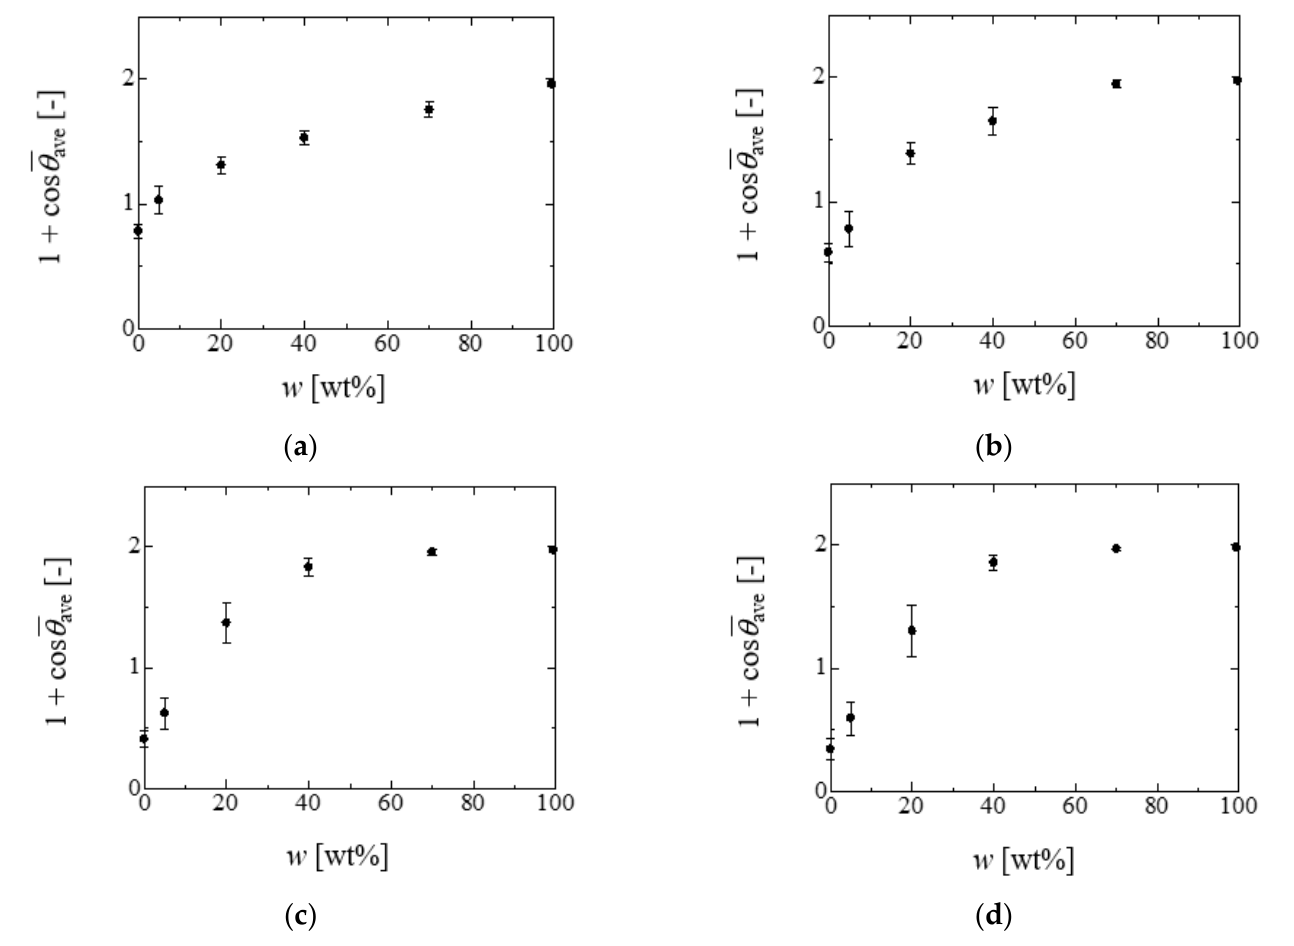
Figure 6. Example of contact angle at the stationary point θ stat for 40 wt% droplets (5.7 μ L) on bare substrate. Snapshots of droplets released from ( a ) 5mm, ( b ) 10 mm, and ( c) 50 mm height. θ stat is evaluated by simple averaging procedure as ( θ L stat + θ R stat )/2.